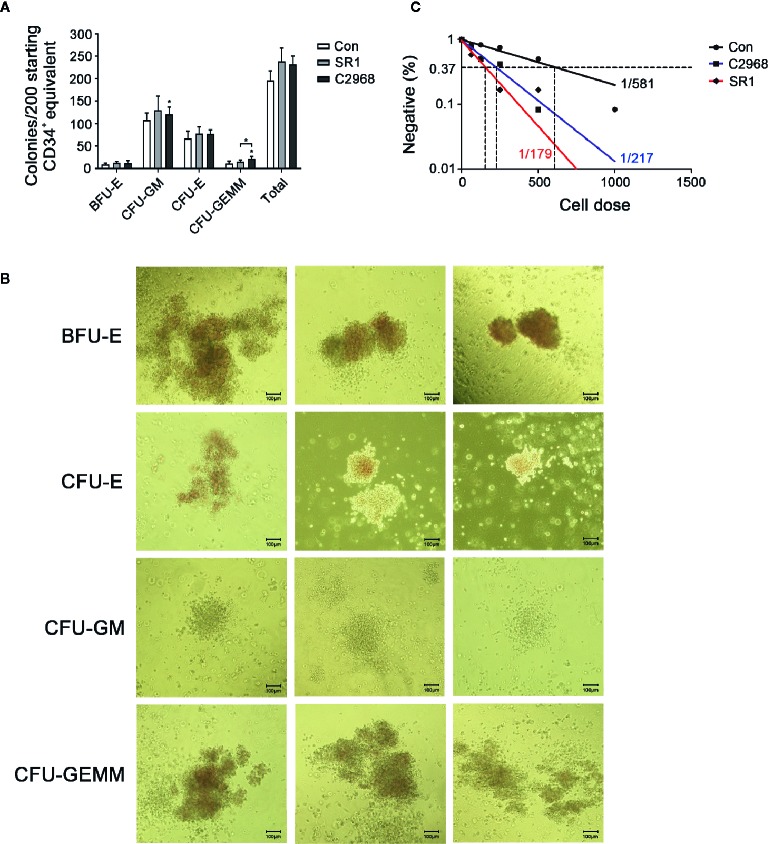
Chrysin-treated CD34+ cells sustained in vitro multiple-differentiation potential and long-term hematopoietic capacity in culture. (A) Colonies derived from multipotent progenitor cells (BFU-E, burst-forming unit-erythroid; CFU-GM, colony-forming unit-granulocyte/macrophage; CFU-E, colony-forming unit-erythrocyte; CFU-GEMMs, colony-forming unit-granulocyte/erythrocyte/macrophage/megakaryocyte) after 14 days in H4434 methylcellulose culture (n = 4). (B) Representative morphological images of CFU colonies described in (A). (C) Frequency of long-term repopulating cells within Con (DMSO 0.01%), SR1 (1 µM), or C2968 (2.5 µM) cultures measured by LDA. Positive well was defined as having more than one cobblestone-like primitive hematopoietic area. All data represent the means ± SD. Compared with control unless specified, *p < 0.05 by two-tailed unpaired t-test.